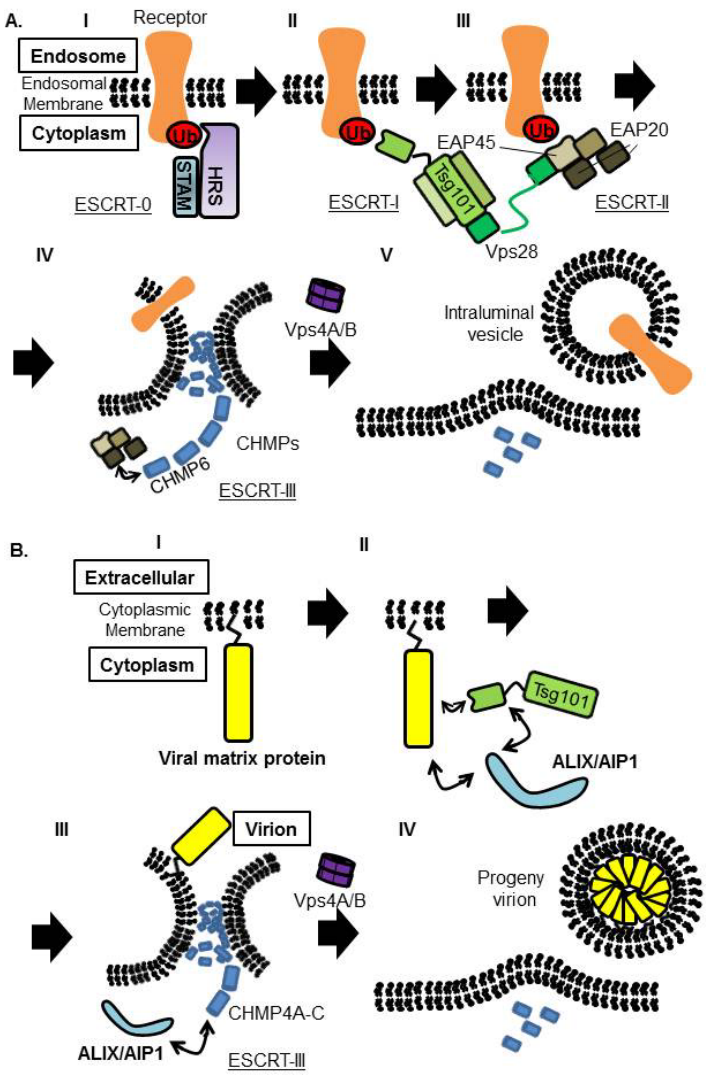
Figure 6. Proposed model of receptor sorting and virus budding. ( A ) Model of receptor sorting. Ubiquitinated receptor is recognized by ESCRT-0, followed by Tsg101, one of the ESCRT-I components. ESCRT-II is proposed to connect ESCRT-I and ESCRT-III. ESCRT-III and the AAA ATPase Vps4A/B trigger the membrane scission to form intraluminal vesicle inside the endosome. ( B ) Viral matrix protein attached to PM and is recognized by Tsg101. Tsg101 binds to ALIX/AIP1 directly, and ALIX/AIP1 also binds to CHMP4, members of the ESCRT-III components to induce vesicle formation. It is not fully understand how ESCRT-I and ESCRT-III is connected in the virus budding procedure. ESCRT-III complex is disassembled by Vps4A/B, for recycling and initiation of new rounds of sorting or